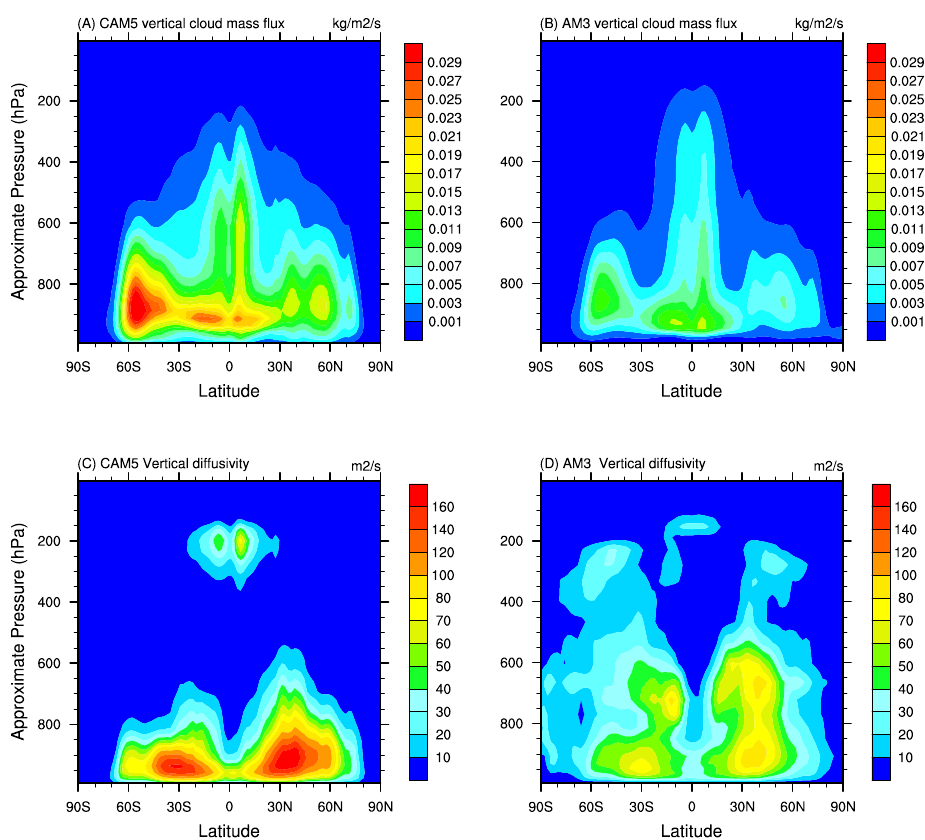
Fig. 2. Annual zonal mean convective cloud mass flux (top) and vertical diffusivity coefficient (bottom) from CAM5 (left) and AM3